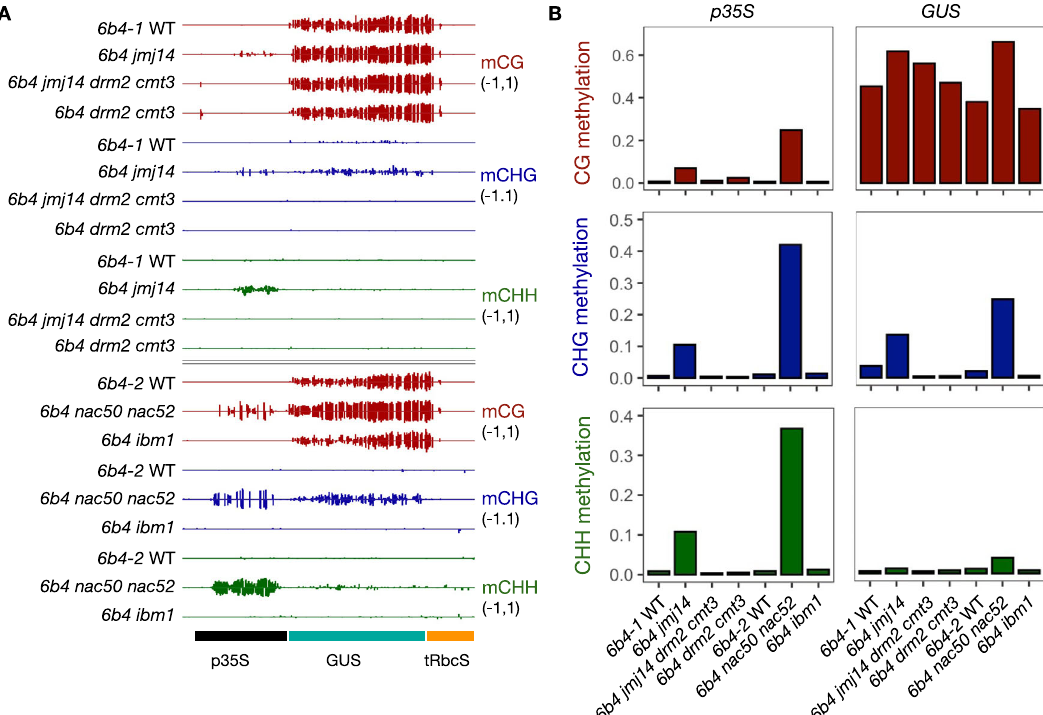
Fig. 5 JMJ14 and NAC50/NAC52 prevent CHG and CHH methylation of the p35S:GUS transgene. A CG, CHG and CHH methylation (where H = A, C or T) pro fi les for the 6b4 GUS transgene consisting of a modi fi ed 35S promoter ( p35S ), the GUS coding sequence ( GUS ) and a Rubisco terminator ( tRbcS ). The top panel shows DNA methylation pro fi les of 5-week-old plants for 6b4 WT control 1 ( 6b4-1 WT), and mutants 6b4 jmj14 , 6b4 jmj14 drm2 cmt3 and 6b4 drm2 cmt3 . The bottom panel shows DNA methylation pro fi les of 8-week-old plants for 6b4 WT control 2 ( 6b4-2 WT) and mutants 6b4 nac50 nac52 and 6b4 ibm1 . Bisul fi te data were analyzed using R version 4.0.2. B Proportion of methylated cytosines in the three sequence contexts across the p35S and GUS sequences show that increased CHG and CHH methylation in 6b4 jmj14 and 6b4 nac50 nac52 plants is dependent on the DRM2-CMT3 pathway, and that impairment of IBM1, if anything, decreases rather than increases DNA methylation of the GUS coding sequence.